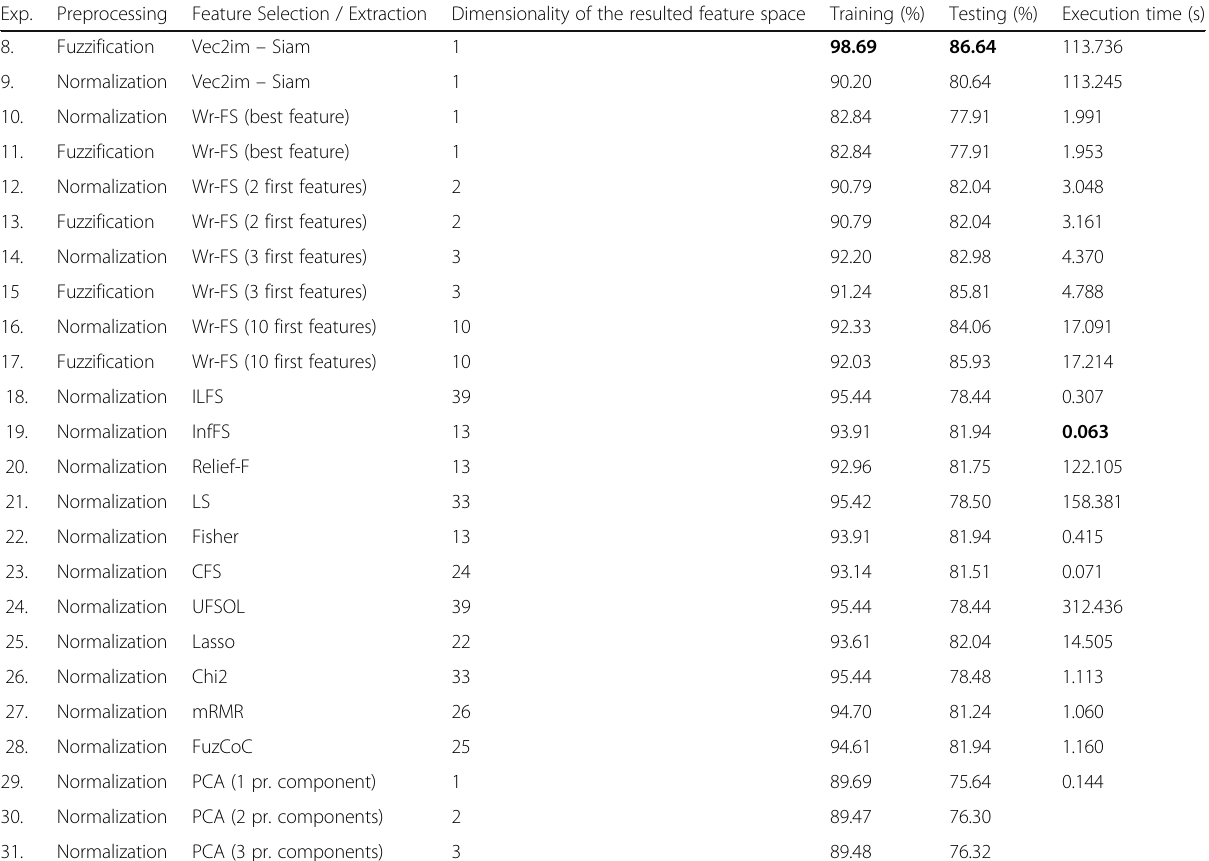
Table 4 Comparative analysis with respect to competing feature selection / extraction techniques using the same classifier